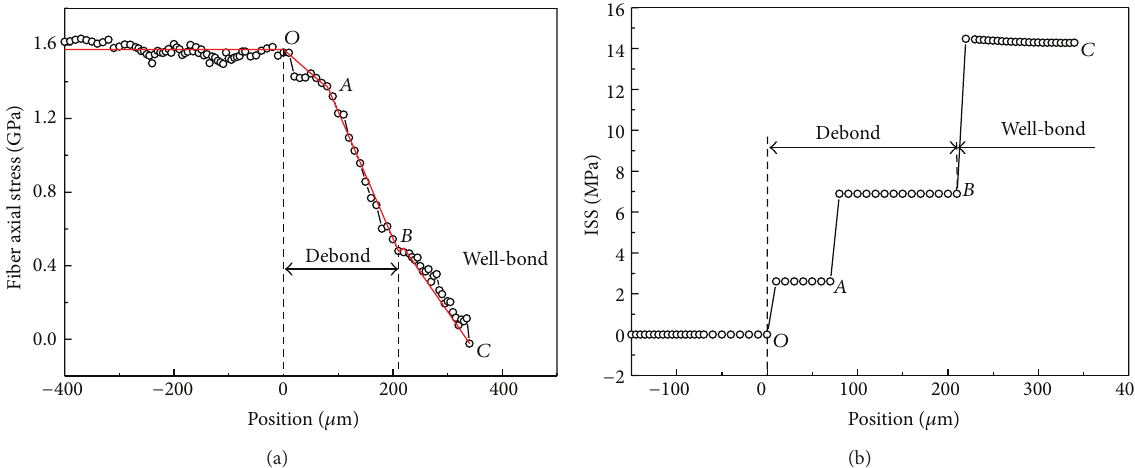
Figure 7: (a) Fiber axial stress and (b) shear stress distributions along fiber of pullout specimen under 1.6% strain